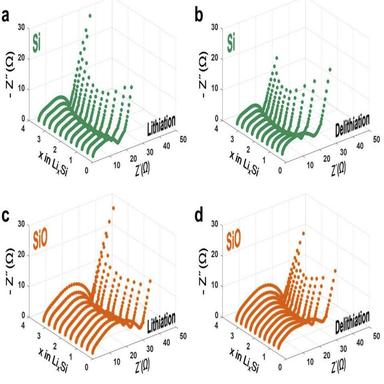
Nyquist plots of Si and SiO anodes at different Li-contents (x) in LixSi measured during (a,c) lithiation (b,d) delithiation at 25 °C.